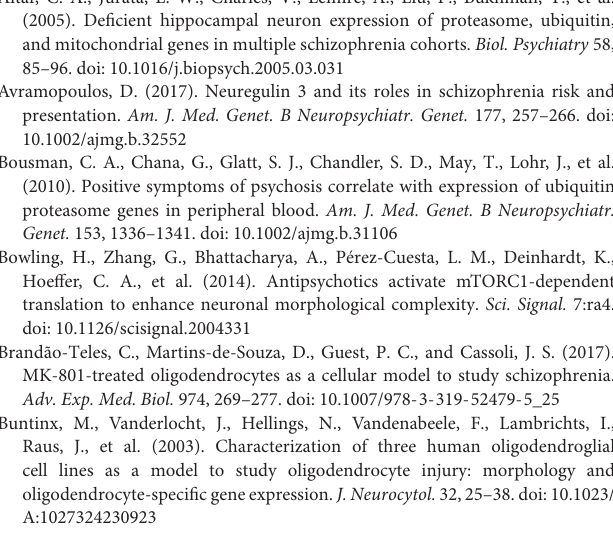
TABLE S1 | Proteins affected by chlorpromazine treatment. TABLE S2 | Proteins affected by haloperidol treatment.